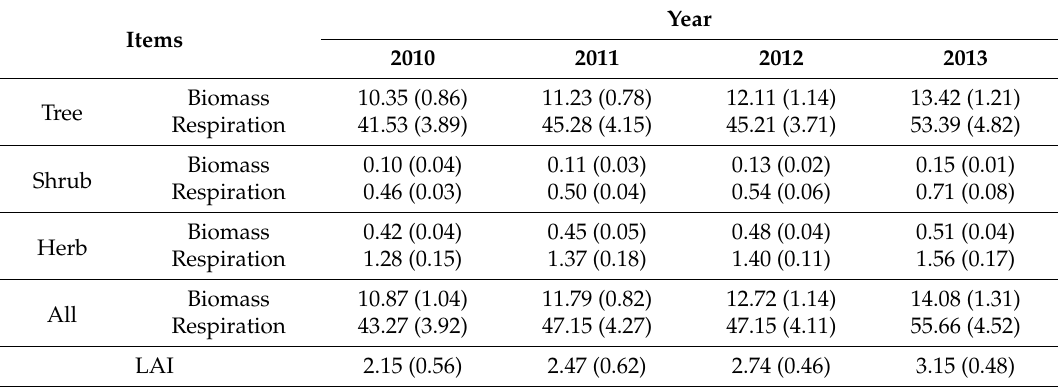
Table 3. Leaf dry biomass (t · ha − 1 ) and leaf respiration per ground area (g · C · m − 2 · y − 1 ) for trees, shrubs, and herbs, and leaf area index (LAI) during 2010–2013.